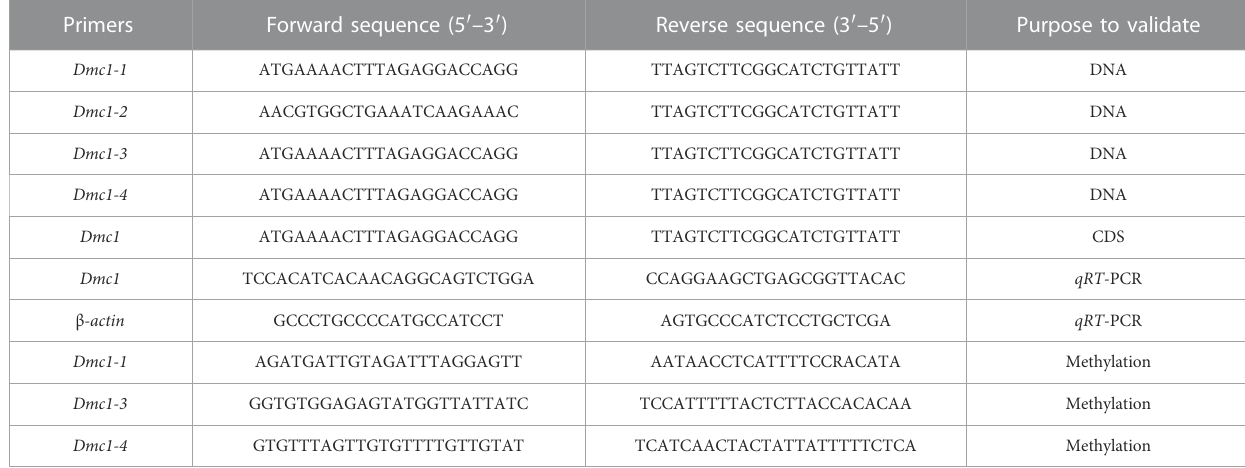
TABLE 1 The primer information used for validation of CDS and DNA, methylation primers, and assessment of relative expression levels through qRT -PCR. Primers Forward sequence (5 ′ – 3 ′ ) Reverse sequence (3 ′ – 5 ′